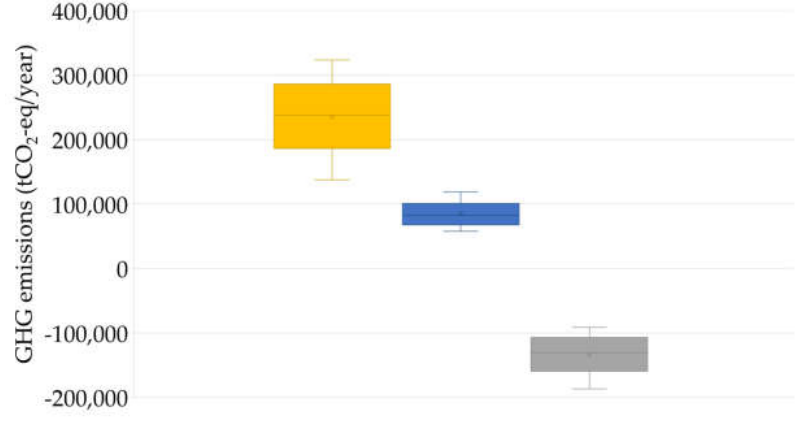
Figure 4. Net GHG emissions of WTE technologies .